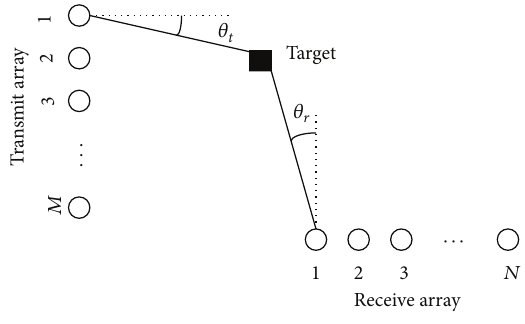
Figure 1: Bistatic MIMO radar